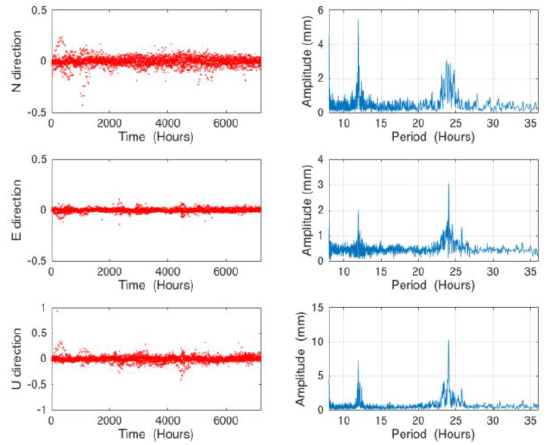
Figure 3. Coordinate time series (left) and spectrum analysis (right) of GDST